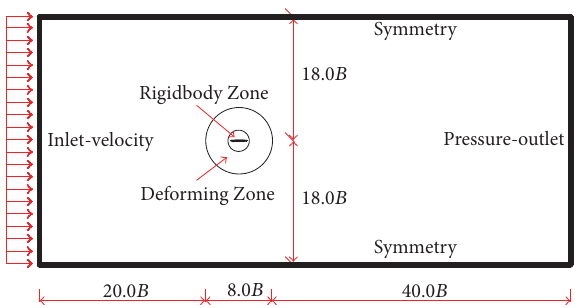
Figure 6: Geometry and boundary conditions of VIV simulation in CFD.